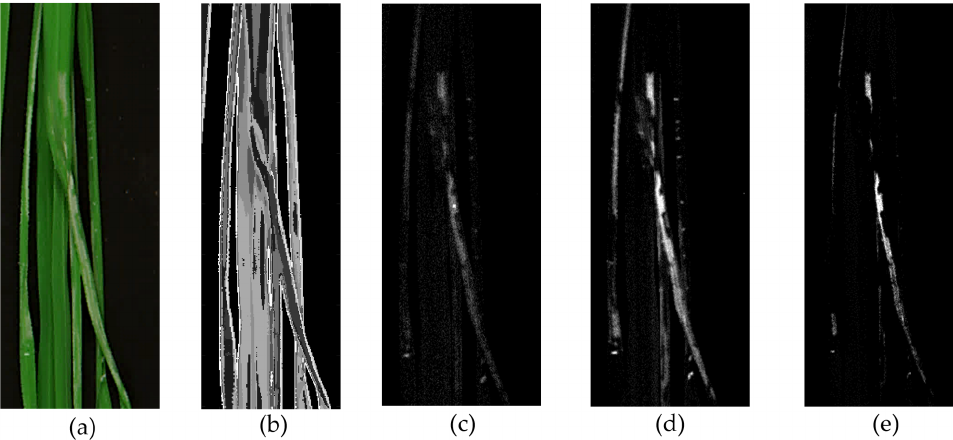
Figure 9. Region of interest detection with k-means (k = 10) or constrained energy minimization algorithm on different datasets using the reflectance of the D1 ocher patch as a d value on rice leaves. ( a ) True-color image, ( b ) k-means in full bands, ( c ) CEM in full bands, ( d ) band selection, and ( e ) band expansion